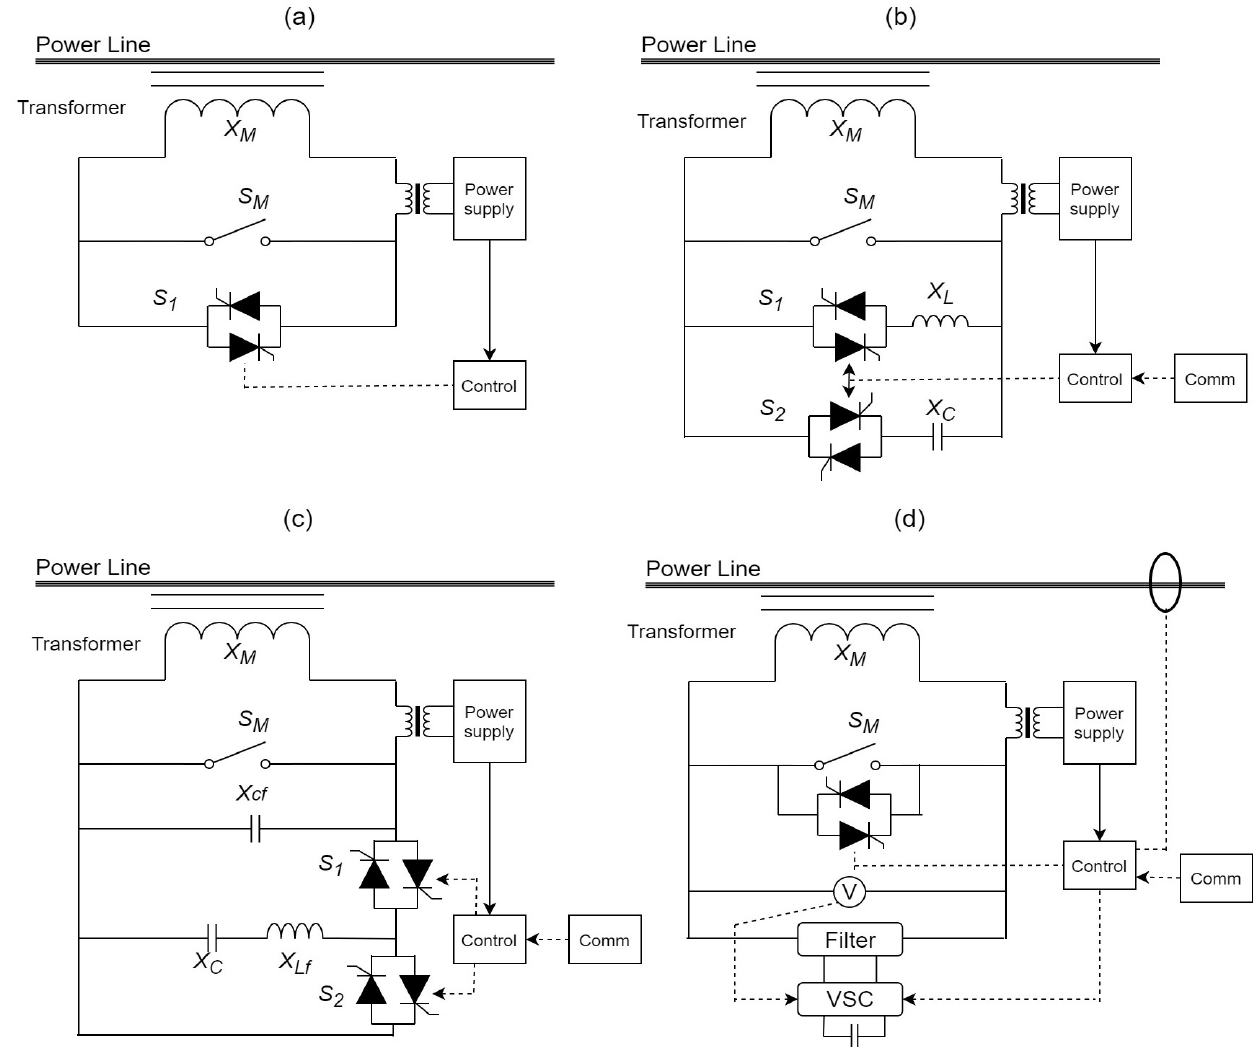
Figure 13. Different schemes for Distributed SSSC (DSSC): ( a ) Distributed Series Reactor (DSR) [202], ( b ) Distributed Series Impedance (DSI) [202], ( c ) Inverter-less Static Series Compensator [204], and ( d ) DSSC with inverter